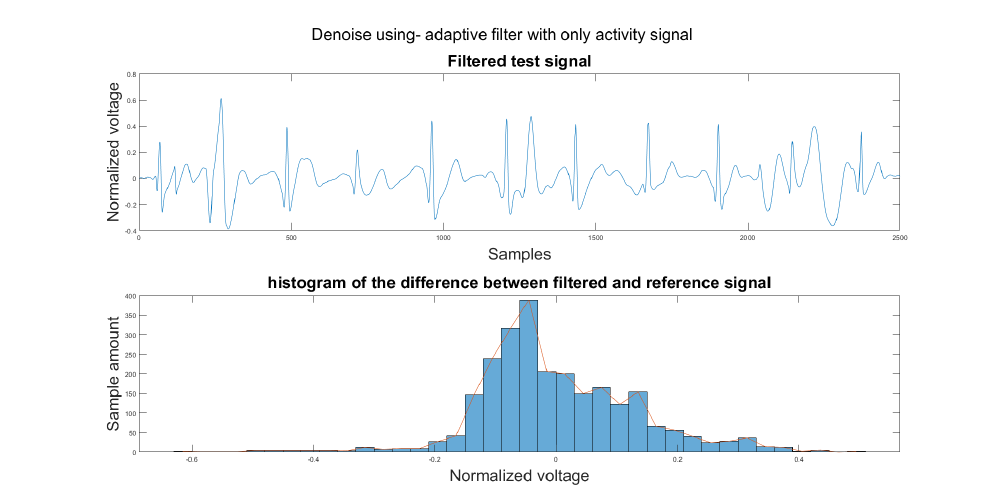
Figure A42. (1) Test signal, (2) histogram of the